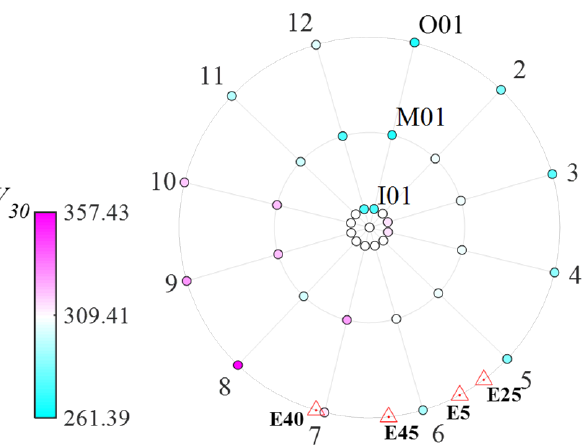
Figure 1. Layout of the SMART 1 array and the azimuth directions of different events relative to the central station.